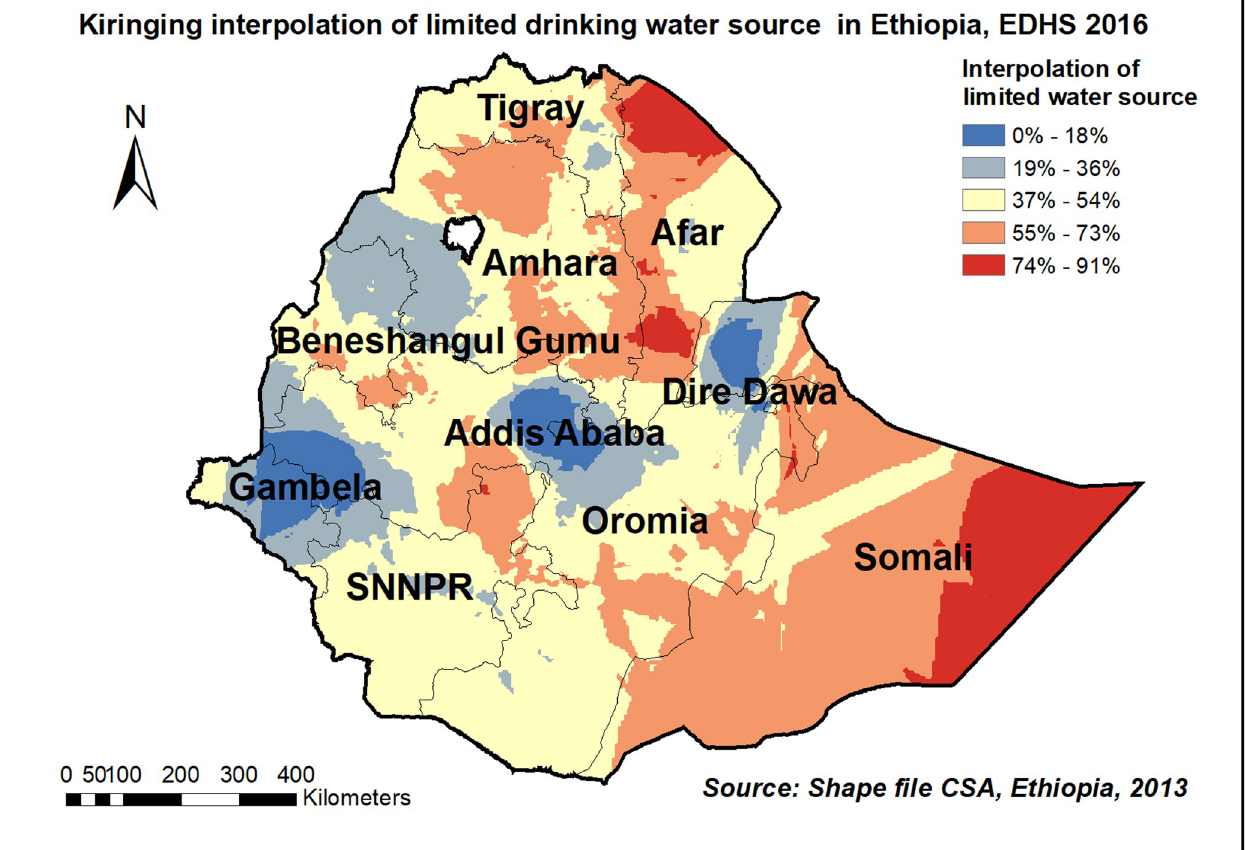
Fig 3. Kiringing interpolation of limited drinking water source in Ethiopia, EDHS 2016, shapefile from 2018 GADM and plotted using ArcMap version 10.7 software.